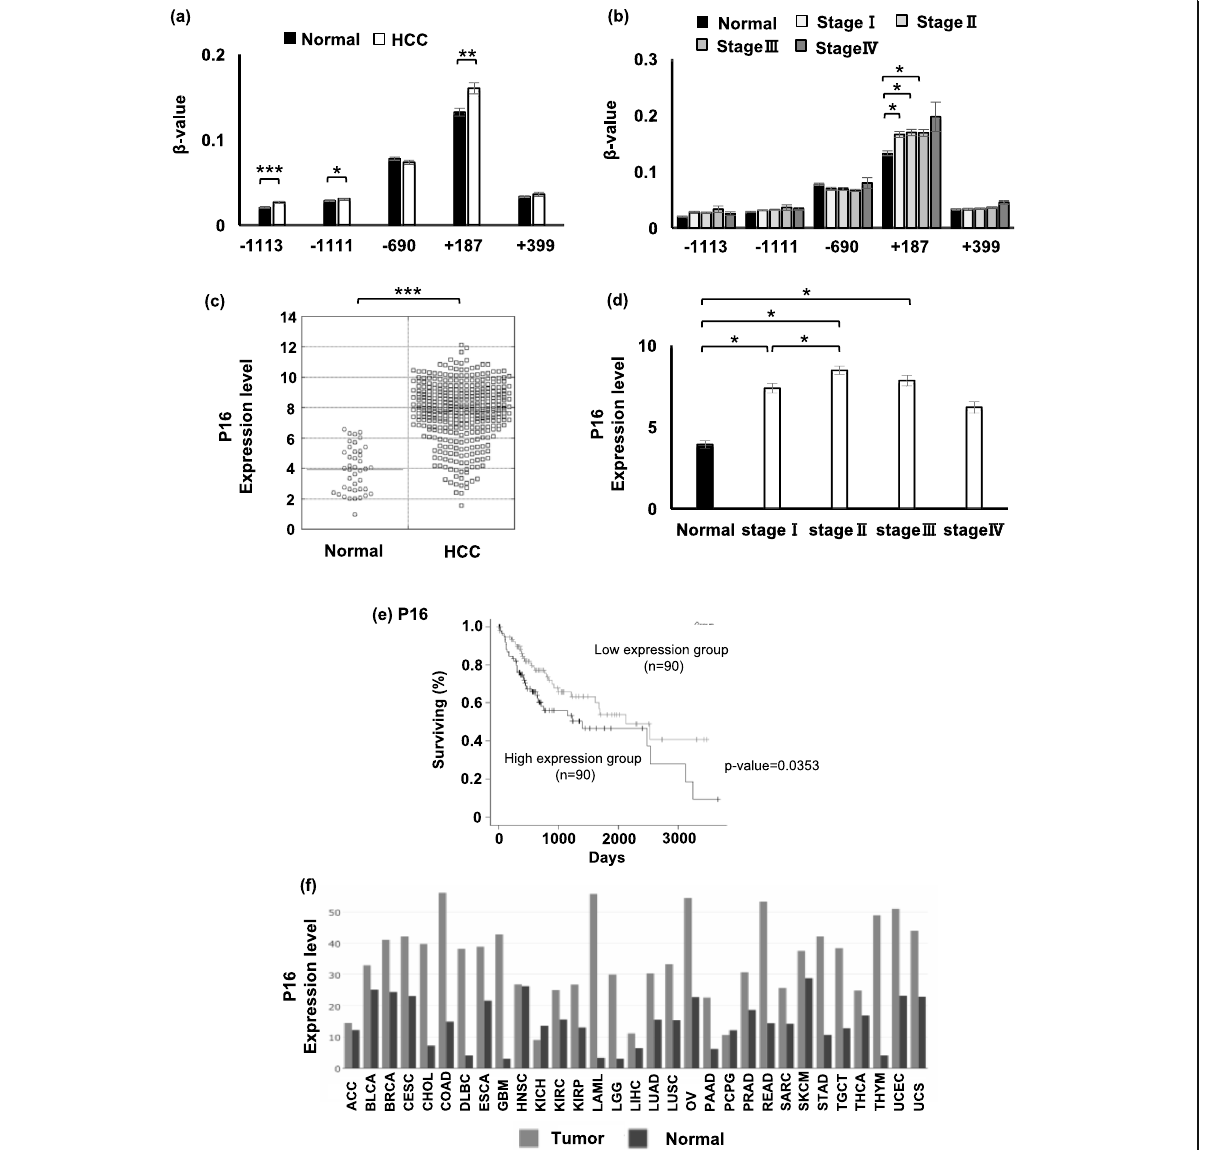
Fig. 6 DNA methylation, gene expression, and survival analysis of P16 gene. a The β values in the 74 HCC tissues highly expressing P16 and in 41 non-tumor tissues. Statistical significance between the two groups was analyzed by Student ’ s t test. *. **. *** Significantly different at p < 0.05, p < 0.01, and p < 0.001 respectively. b The β values of P16 in HCC tissues of pathological stages I, II, III, and IV and non-tumor tissues. Statistical significance was analyzed by one-way ANOVA followed by Turkey-Kramer test as a post hoc comparison. * Significantly different at p < 0.05. c The expression levels of P16 in HCC tissues and non-tumor tissues. d The expression levels of P16 in HCC tissues of pathological stages I, II, III, and IV and non-tumor tissues. e Kaplan-Meier analyzes for 90 HCC patients with higher and lower expression of P16 . f The expression levels of P16 in various types of cancers. Light black and dark black bars indicate expression in tumor tissues and non-tumor tissues, respectively. ACC adenoid cystic carcinoma, BLCA bladder carcinoma, BRCA breast invasive carcinoma, CESC cervical squamous cell carcinoma, CHOL cholangiocarcinoma, COAD colon adenocarcinoma, DLBC diffuse large B cell lymphoma, ESCA esophageal carcinoma, GBM glioblastoma, HNSC head-neck squamous cell carcinoma, KICH kidney chromophobe, KIRC kidney renal clear cell carcinoma, KIRP kidney renal papillary cell carcinoma, LAML acute myeloid leukemia, LGG low-grade glioma, LIHC liver hepatocellular carcinoma, LUAD lung adenocarcinoma, LUSC lung squamous cell carcinoma, OV ovarian cancer, PAAD pancreatic adenocarcinoma, PCPG pheochromocytoma and paraganglioma, PRAD prostate adenocarcinoma, READ rectum adenocarcinoma, SAC sarcoma, SKCM skin cutaneous melanoma, STAD stomach adenocarcinoma, TGCT testicular germ cell tumors, THCA thyroid cancer, THYM thymoma, UCEC uterine corpus endometrial carcinoma, UCS uterine